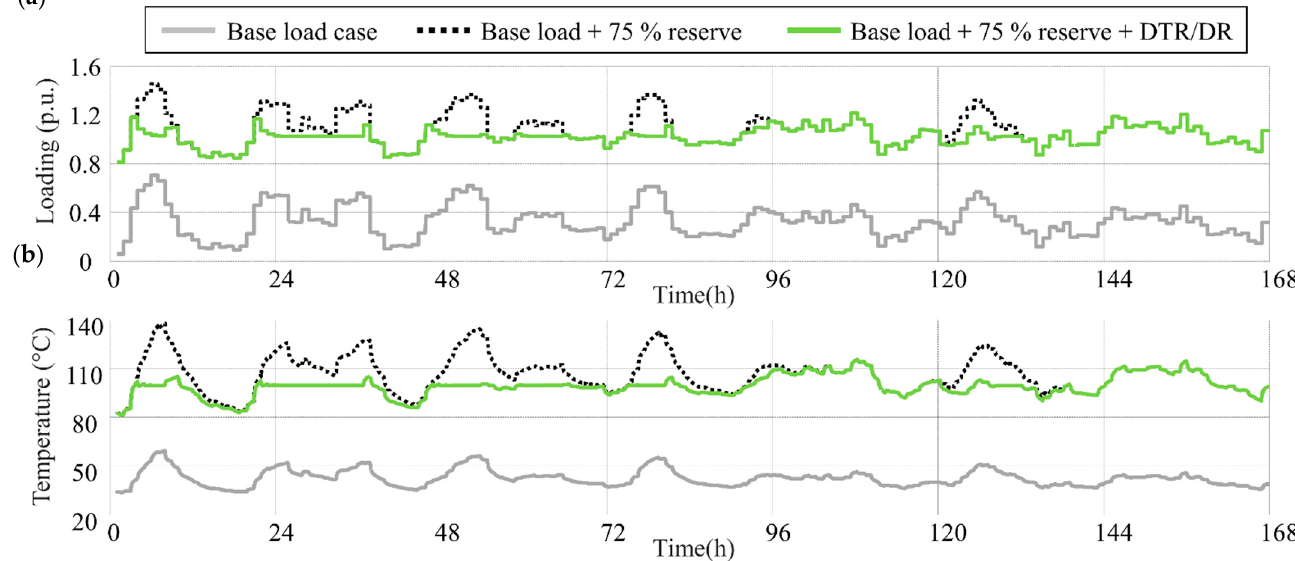
Figure 13. One-week profiles in January, comparison of the base case and Dynamic Thermal Rating (DTR)/DR in “energy-shedding mode”: ( a ) transformer loading; ( b ) hot-spot temperature.